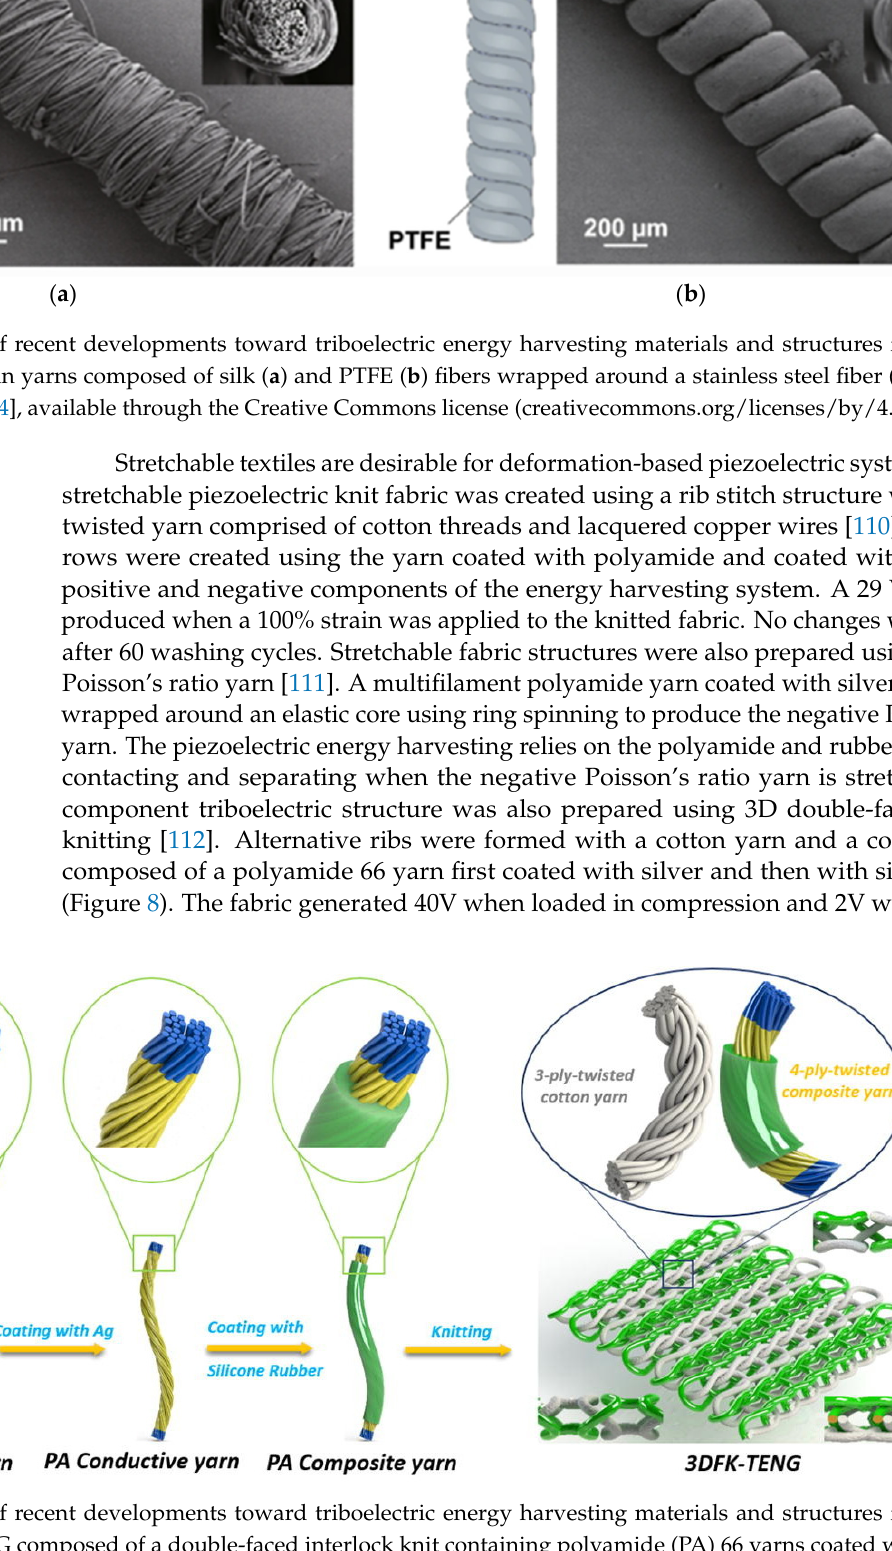
( b ) Figure 6. Examples of recent developments toward triboelectric energy harvesting materials and structures for textile application: ( a ) TiO 2 flowers decorating a stainless steel textile (reproduced from [96] with permission from Elsevier); ( b ) CNT decorating a velvet fabric (reproduced from [100] with permission from ACS Publications). 4.2. Fibers/Textiles A silk-based triboelectric energy harvesting system was developed with the aim of providing an optimal trade-off between triboelectric and mechanical performance while preserving the flexibility for textile applications [104]. It is based on core-spun yarns (Fig- ure 7). The electropositive side involves a stainless steel fiber core and a silk fiber wrapped sheath while the electronegative side is composed of a stainless steel fiber core and a PTFE fiber wrapped sheath. Two types of textile structures were produced using weaving and embroidery. These processes are easily scalable to production and allowed producing tri- boelectric energy harvesting devices with high strength, good energy generation output and great durability. A similar configuration of core-spun yarns produced with a stainless steel core and polyurethane wrapped sheath woven into a fabric was assessed with a se- ries of typical clothing materials—polyamide, cotton, wool, polyester, and polyacryloni- trile—and exhibited output voltages between 20 and 80 V [105]. PVDF fibers were also electrospun on a CNT yarn core acting as the electrode [106]. When tested against a poly- amide counter material on an electrode in contact–separation mode at 2 Hz and 10 N to simulate a heel strike, the PVDF-CNT coaxial yarn provided an output of 20 μ W cm − 2 . The yarn exhibited a good durability; the output power increased by about 30% after 200,000